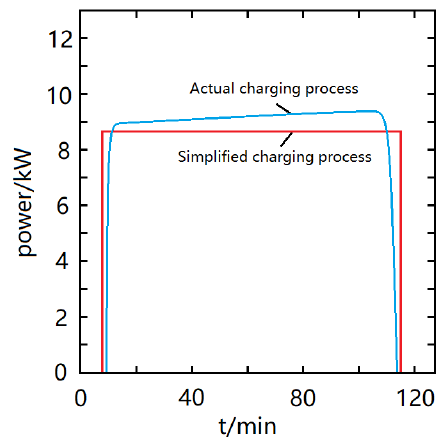
Figure 4. The simplified charging process.